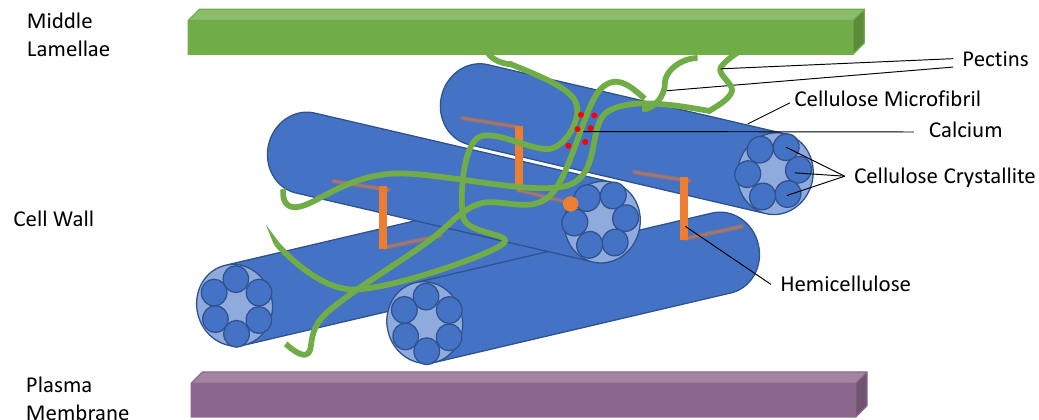
Figure 1. Carbohydrate components of a primary plant cell wall. A cartoon of the carbohydrate components of a primary plant cell wall demonstrating the supramolecular nature of the wall and the diversity of the cell wall constituents which contribute to dietary fibre. The cellulose microfibrils are composed of crystallites which are further composed of cellulose chains. The cellulose microfibrils are stacked upon one another to give strength as the skeleton of the wall. Hemicellulose is thought to keep the microfibrils apart. The nature of hemicellulose present varies considerably between plants. Pectin is a mega molecule, used for water transport throughout the plant. There are various different sections within pectin, the proportions vary between plants. The egg box region is shown here where different strands of pectin are bound together by calcium. There is a high concentration of pectins in the middle lamellae which interact with the neighbouring cell walls [4].